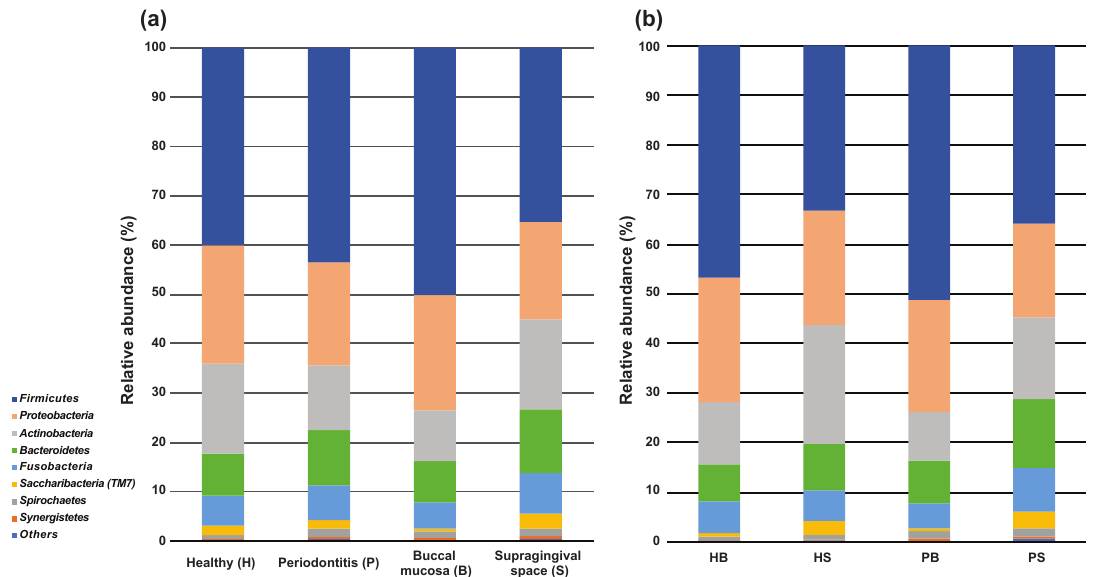
Figure 1. Relative abundance of bacterial phyla grouped by the disease status, sampling sites, and four subject groups. ( a ) Disease status; Healthy (H) vs. Periodontitis (P) and sampling sites; Buccal mucosa ( b ) vs. Supragingival space (S) (B) four subject groups; Healthy_Buccal (HB), Healthy_Supragingival (HS), Periodontitis_Buccal (PB), and Periodontitis_Supragingival